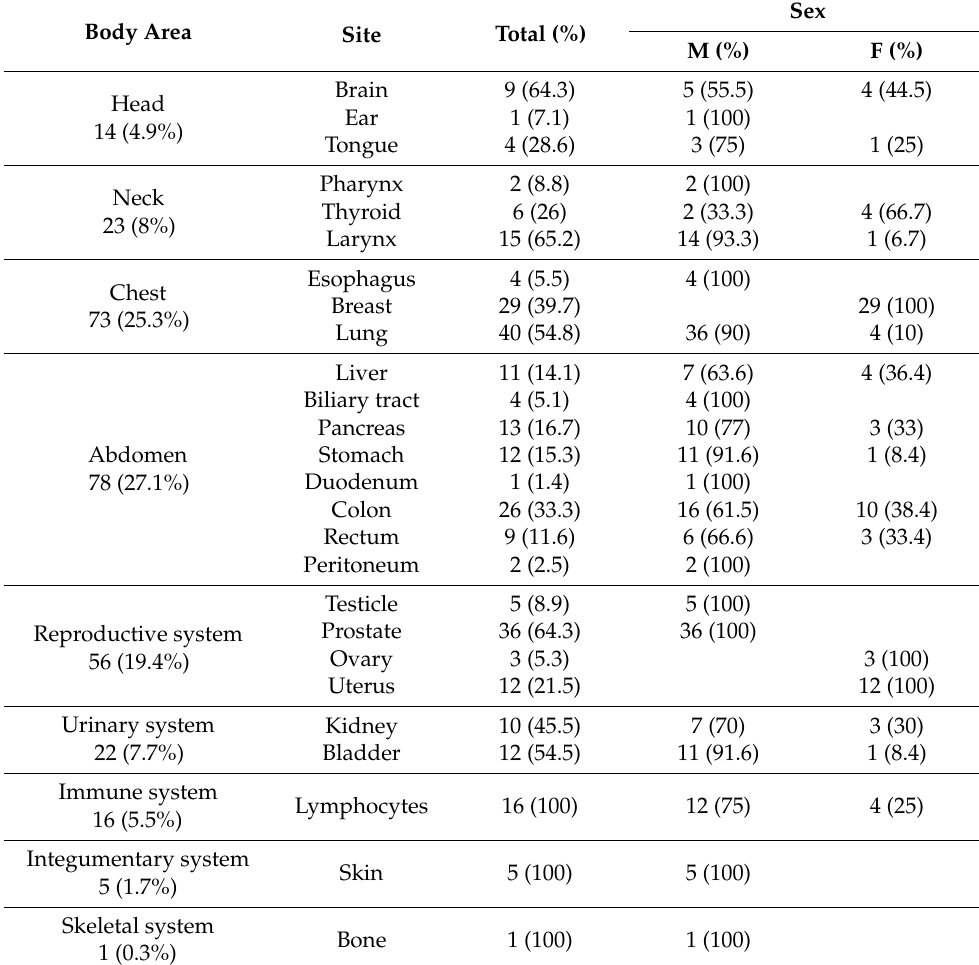
Table 1. Details by anatomical district of the prevalent neoplastic sites according to the victim’s